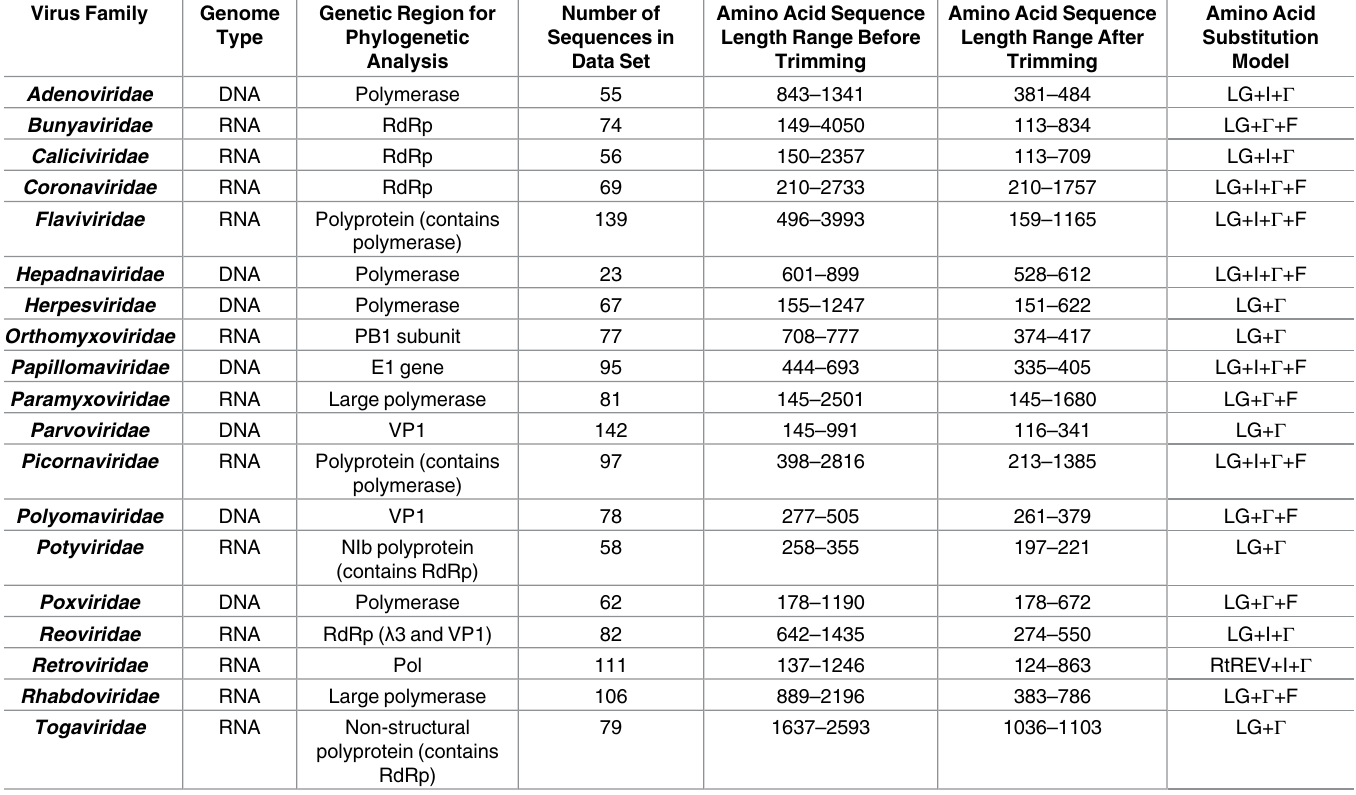
Table 1. Summaryof the virus data used in this study. The best-fit amino acid substitution models were selectedaccordingto the BayesianInformation Criterion. Virus